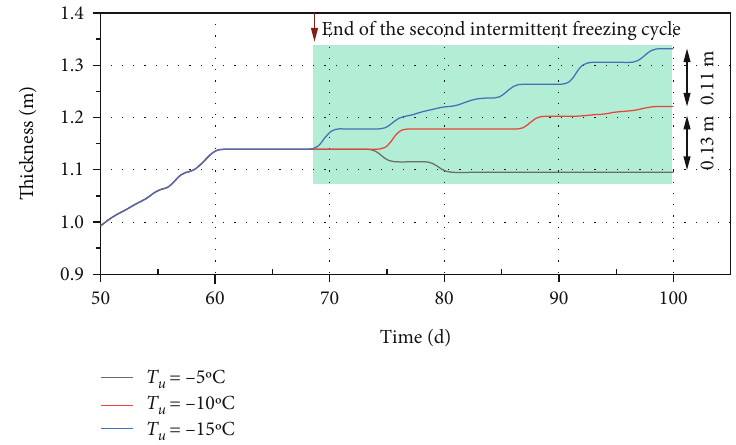
Figure 16: The comparison of di ff erent T